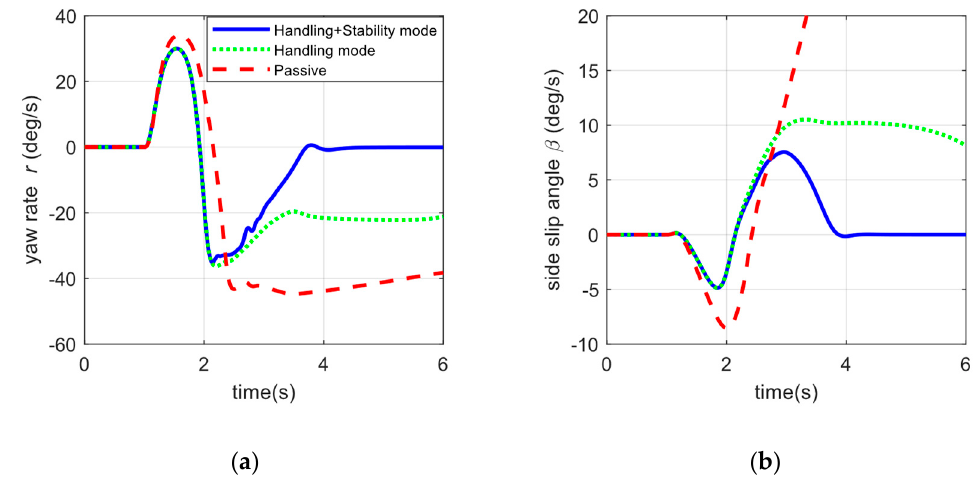
Figure 13. Results in Sine with Dwell stability test: ( a ) Yaw rate responses; ( b ) Side slip angle responses.